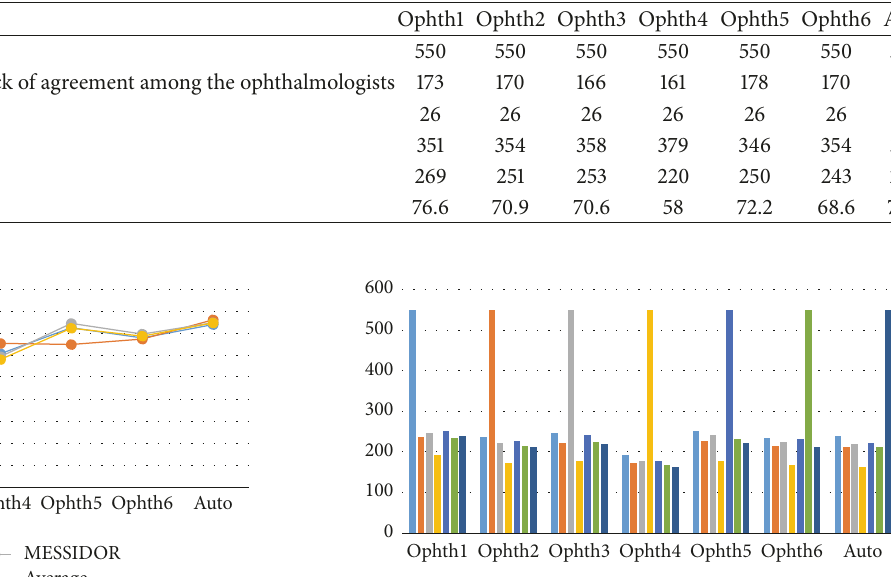
Table 5: The HCDR results for all three images’ set.